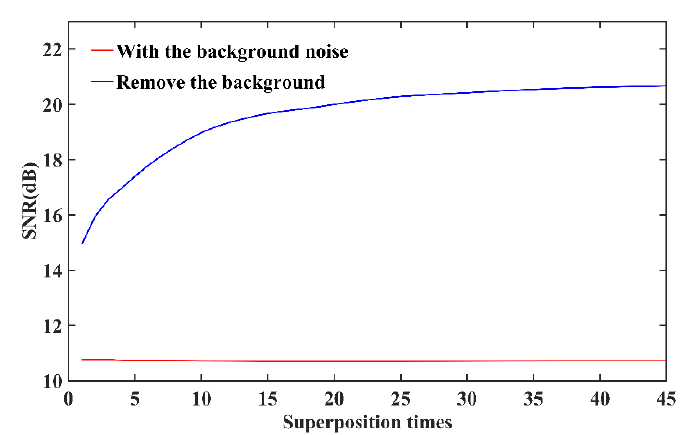
Figure 7. The SNR curves of the image signals with and without background noise as the number of superposition times increases.